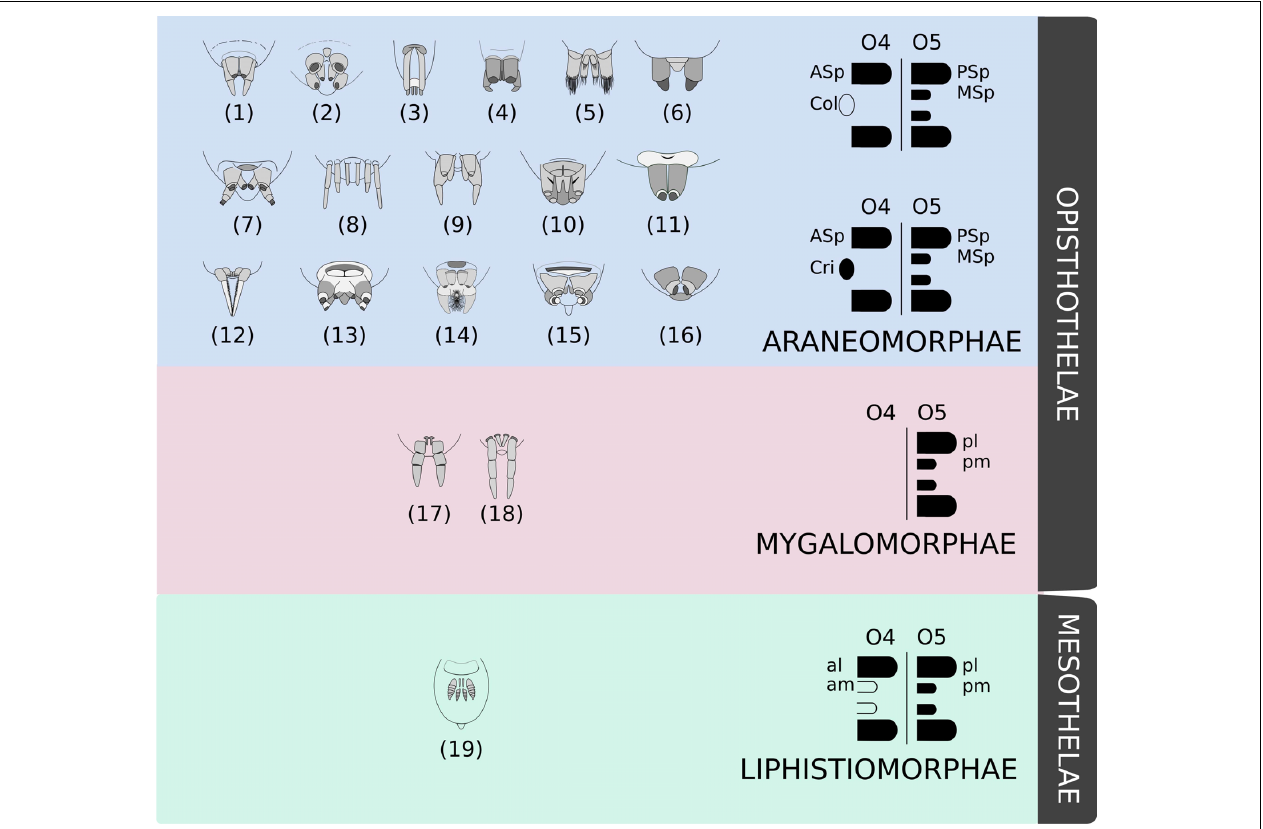
FIGURE 1 | Examples of the diversity of spinneret morphology. Drawings adapted from Brescovit et al. (2002) and Joqué and Dippeaar-Schoeman (2007) showing examples of morphologies of some spider species belonging to different families: (1) Miturgidae , (2) Corinnidae , (3) Gnaphosidae , (4) Clubionidae , (5) Prodidomidae , (6) Senoculidae , (7) Ctenidae , (8) Hahniidae , (9) Agielenidae, (10) Amaurobiidae , (11) Zodariidae , (12) Hersiliidae , (13) Titanoedidae , (14) Oecobidae , (15) Uloboridae , (16) Palpimanidae , (17) Paratropididae , (18) Nemesiidae , and (19) Liphistiidae . These examples are not representative of the familial diversity of Araneae. Mesothelae spiders (green) possess four pairs of spinnerets (at least vestiges) in the middle of the abdomen, whilst Opisthotelae (pink and blue) possess them in the end of the opisthosoma. Mygalomorphae (pink) have a reduced number of spinnerets and Araneomorphae (blue) present a remarkable diversity of organizations (as the colulus or the cribellum). Schematics were based on Hilbrant (2008). Abbreviations: al, anterior lateral spinneret; am, anterior median spinneret; ASp, anterior spinneret; Col, colulus; Cri, cribellum; MSp, median spinneret; pl, posterior lateral spinneret; pm, posterior median spinneret; PSp, posterior